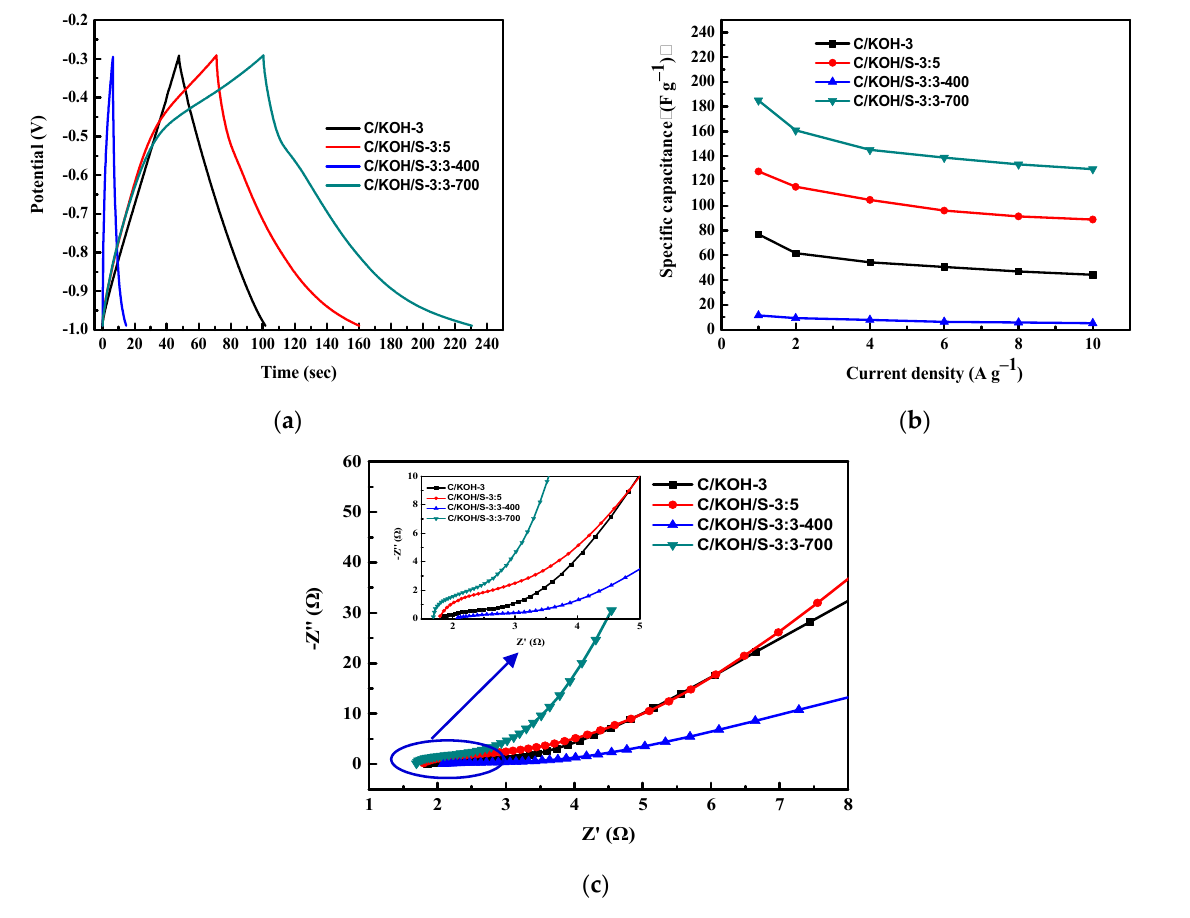
Figure 8. GCD behavior at 1 A g − 1 of different electrodes ( a ), specific capacitance of different electrodes ( b ) and resulting Nyquist plot of the electrodes ( c ).